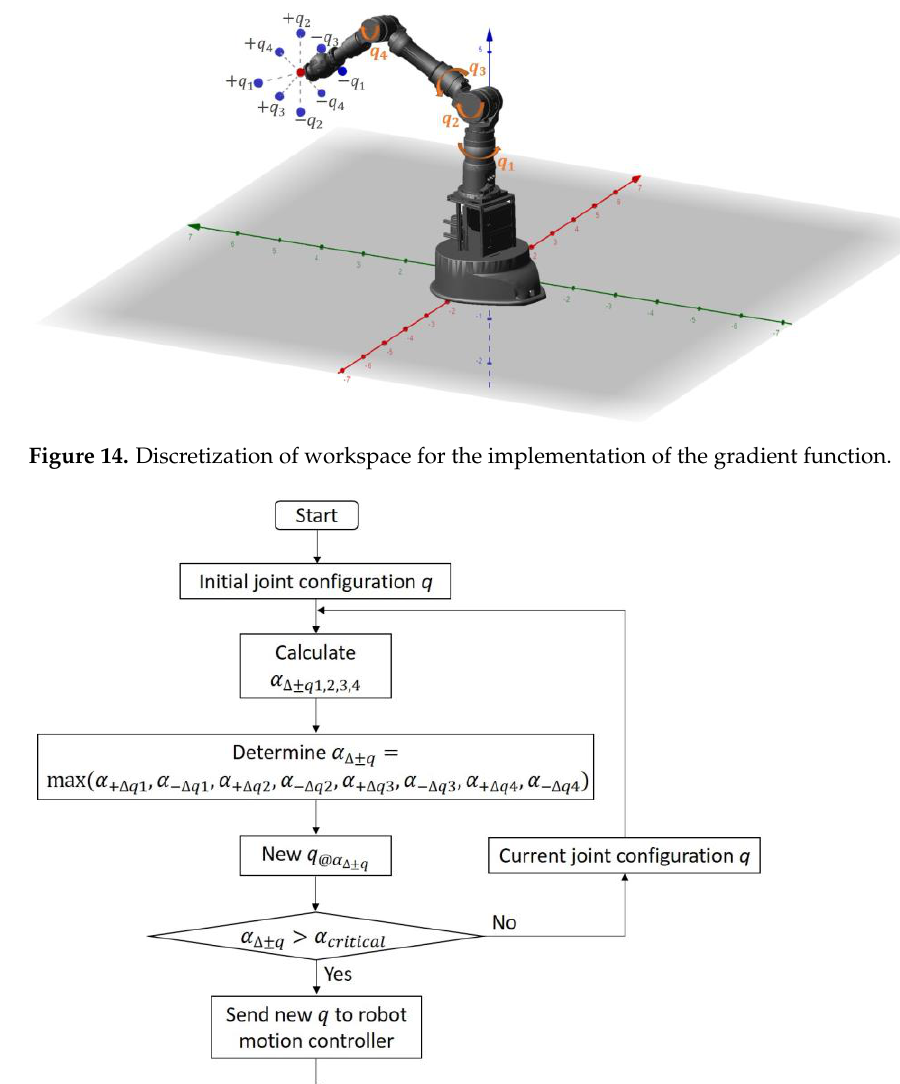
Figure 15. Algorithm for calculating the new joint position for the manipulator.